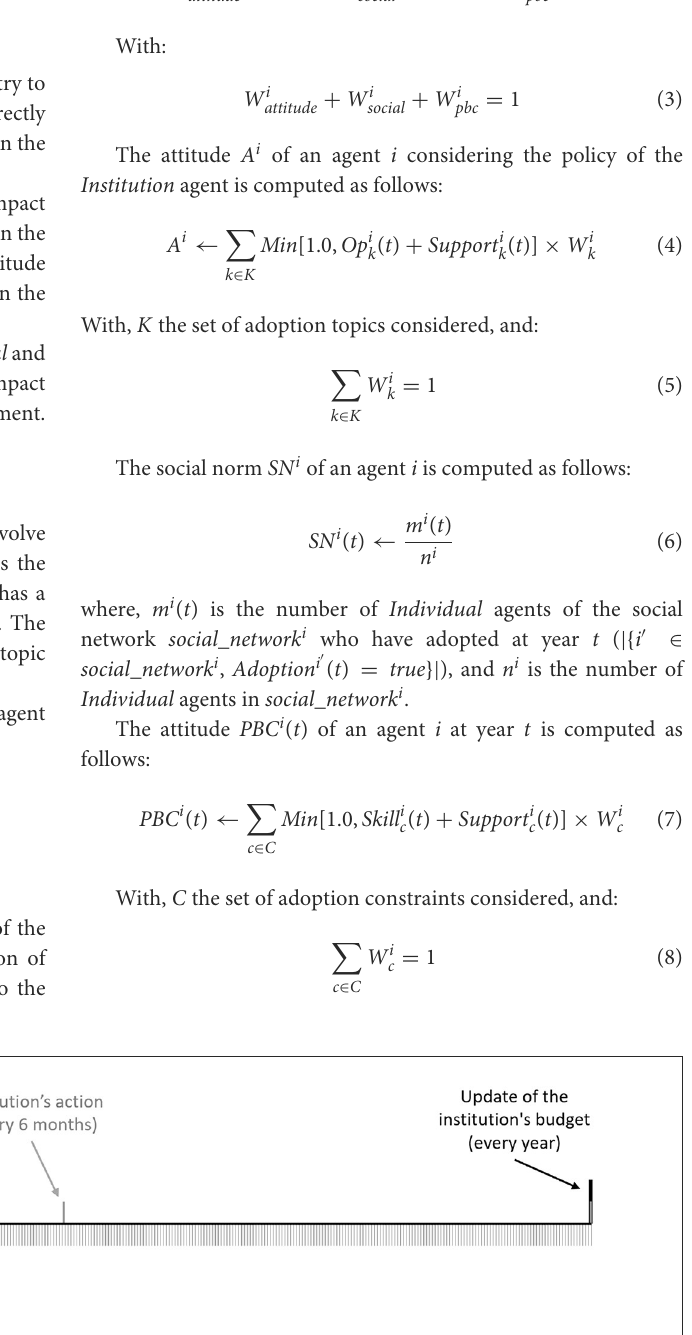
FIGURE1 Time frames considered: every day, interaction of individuals; every 6 month’s, implementation of the actions of the institution; every year, updating of the institution’s